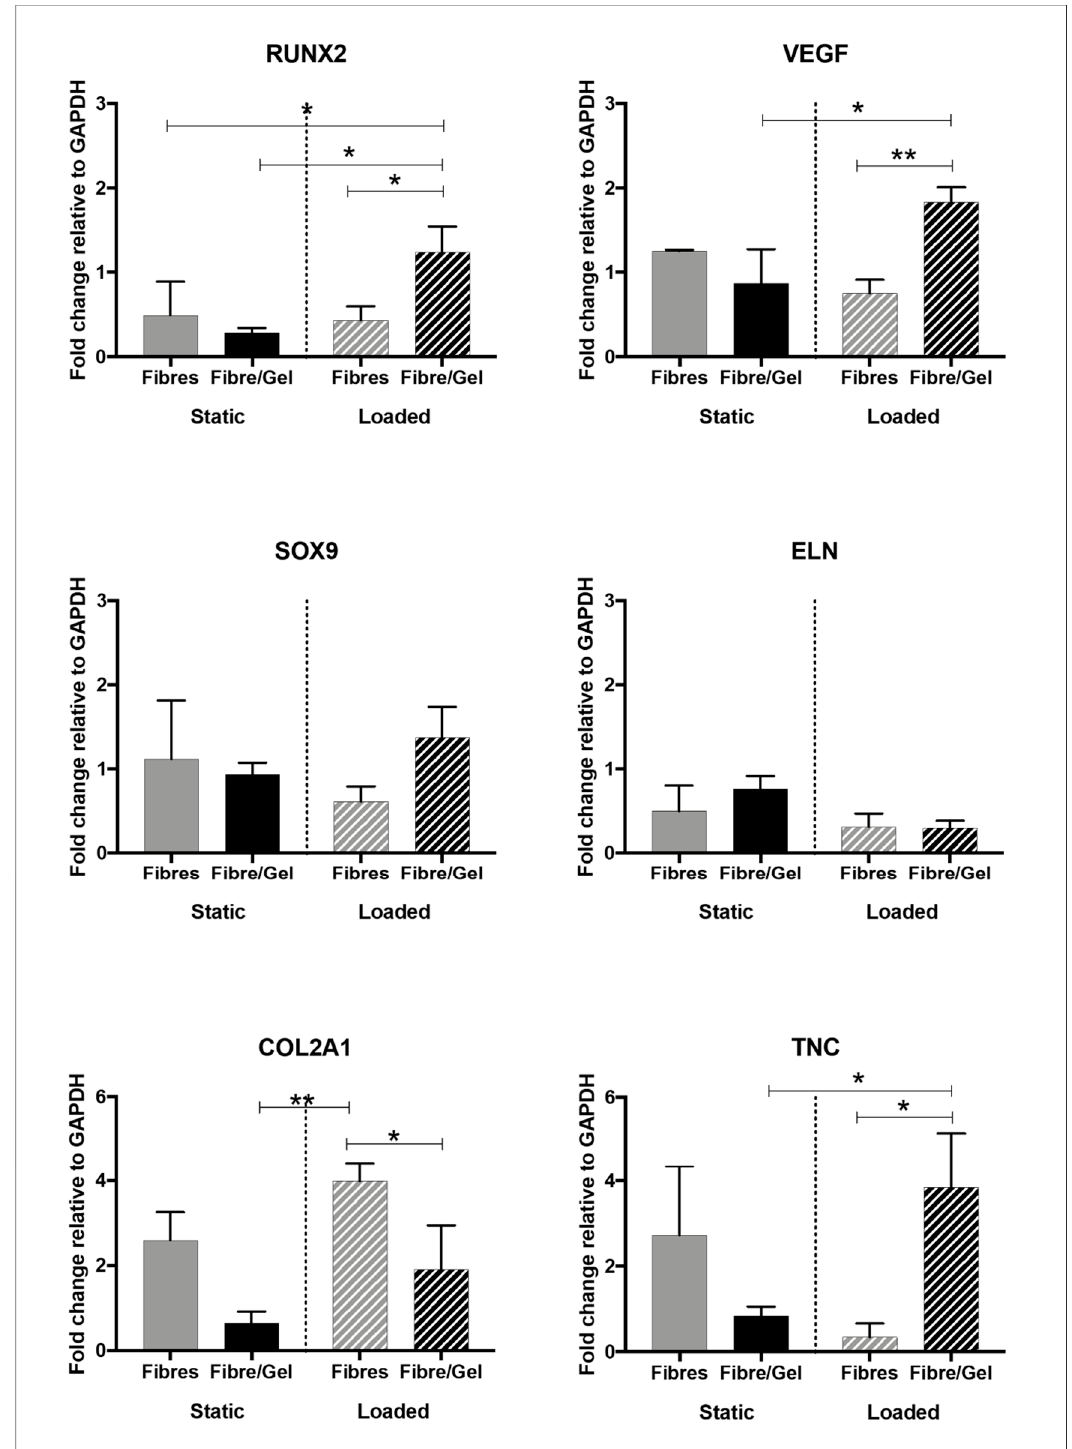
Figure 3. Gene expression for human mesenchymal stem cells demonstrating fold changes for specific genes relative to GAPDH after seven days for the four test groups. Data presented as mean ± standard error, two-way ANOVA, and post-hoc Tukey’s multiple comparisons test (* p < 0.05, ** p < 0.01).